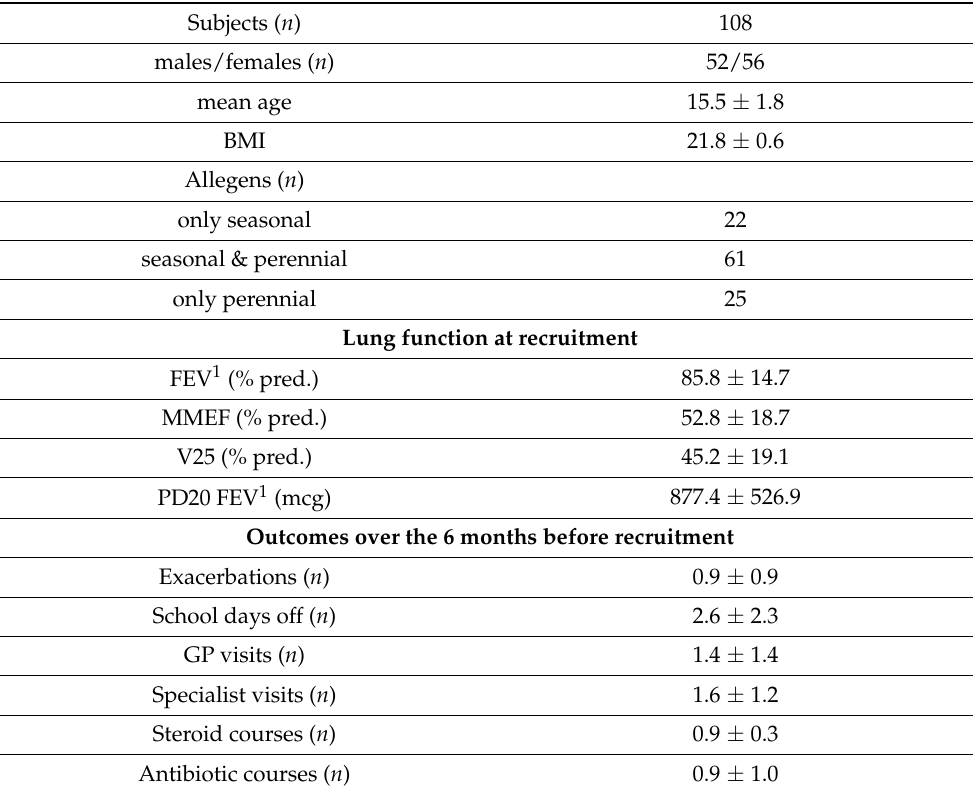
Table 1. General data of the whole sample, together with the mean values of lung function. Param- eters measured at recruitment and health outcomes were assessed over the previous six months. ( n ; %; means ±